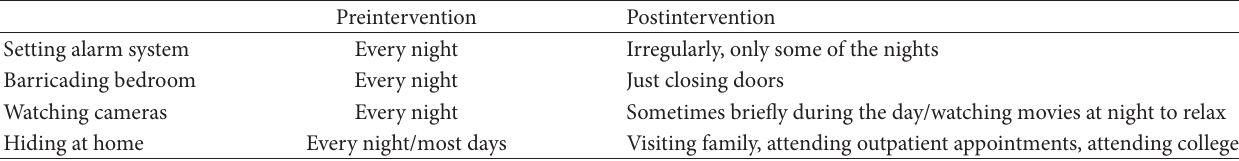
Table 2: Self-reported frequency of safety seeking behaviour.